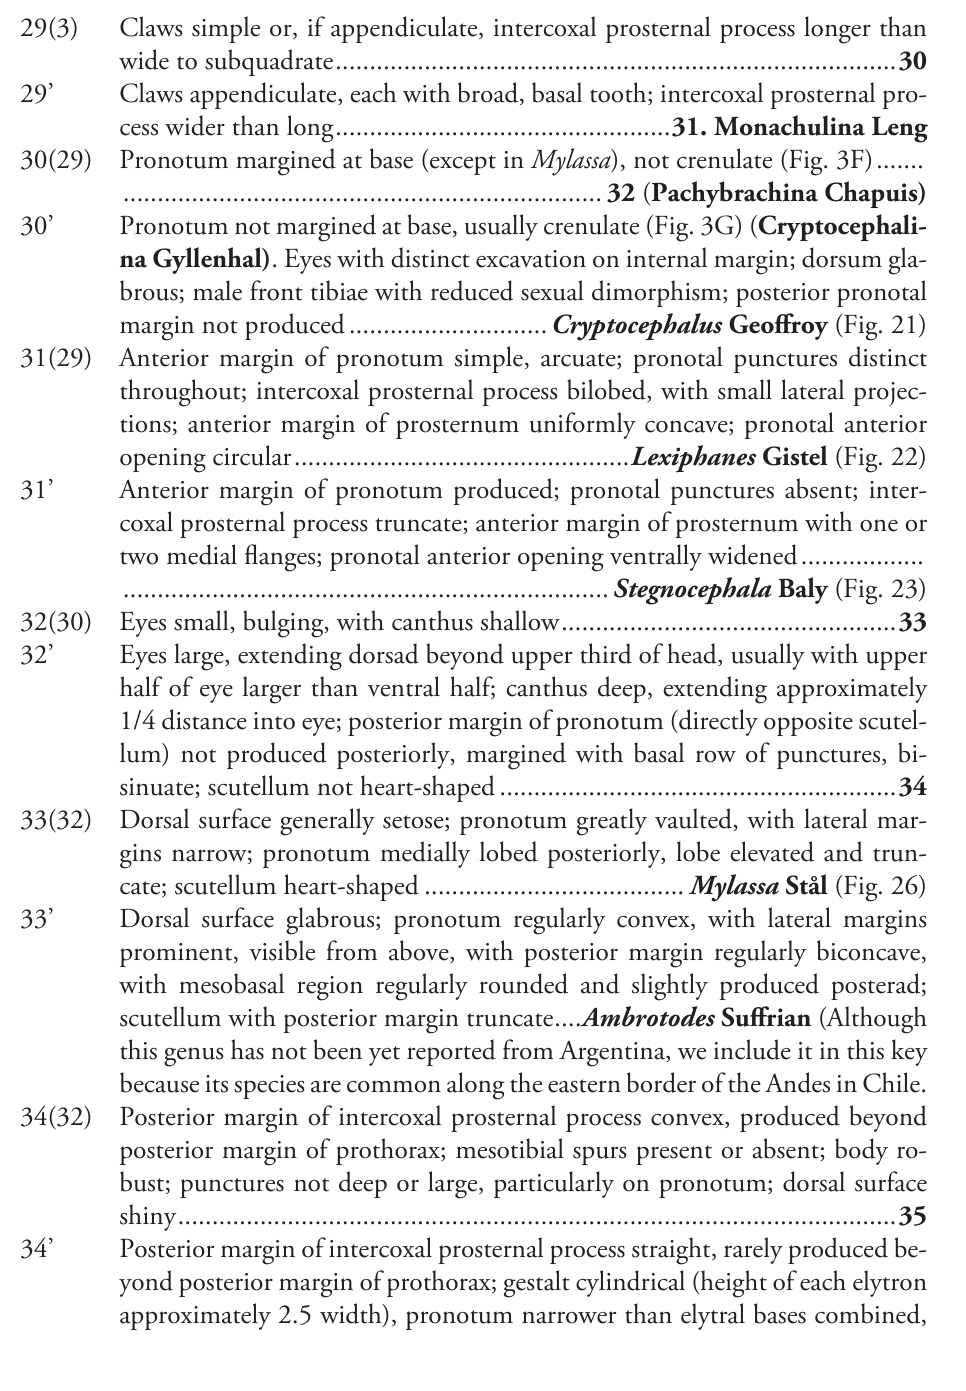
Claws simple or, if appendiculate, intercoxal prosternal process longer than Claws appendiculate, each with broad, basal tooth; intercoxal prosternal pro- Pronotum margined at base (except in Mylassa ), not crenulate (Fig. 3F) ....... Pronotum not margined at base, usually crenulate (Fig. 3G) ( Cryptocephali- na Gyllenhal) . Eyes with distinct excavation on internal margin; dorsum gla- brous; male front tibiae with reduced sexual dimorphism; posterior pronotal Anterior margin of pronotum simple, arcuate; pronotal punctures distinct throughout; intercoxal prosternal process bilobed, with small lateral projec- tions; anterior margin of prosternum uniformly concave; pronotal anterior Anterior margin of pronotum produced; pronotal punctures absent; inter- coxal prosternal process truncate; anterior margin of prosternum with one or